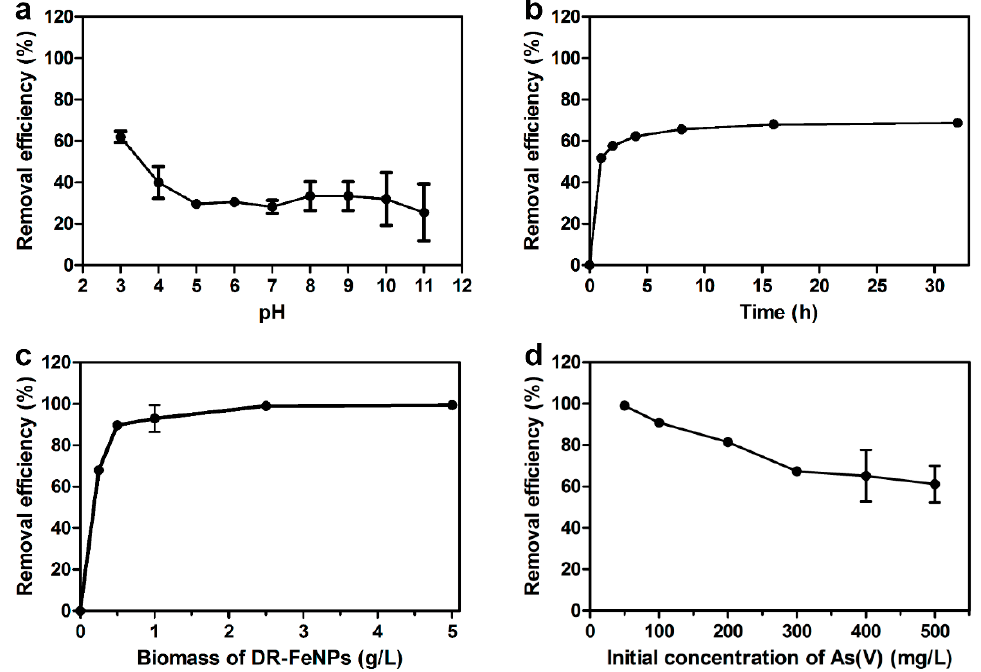
Figure 4. Optimization of adsorption conditions for maximum removal efficiency according to ( a ) pH, ( b ) contact time, ( c ) the amount of biomass, and ( d ) initial concentration of As(V). Experimental conditions were as follows: ( a ) contact time = 24 h, biomass = 0.2 g/L, initial concentration of As(V) = 50 mg/L; ( b ) initial pH = 3, biomass = 0.25 g/L, initial concentration of As(V) = 50 mg/L; ( c ) initial pH = 3, contact time = 16 h, initial concentration of As(V) = 50 mg/L; ( d ) initial pH = 3, contact time = 16 h, biomass = 2.5 g/L. All experiments were performed in triplicate; error bars denote standard deviation.